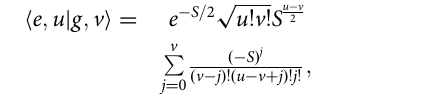
Table 1 Parameters used in the calculation of the relative scattering cross-sections shown in Fig. 1b.